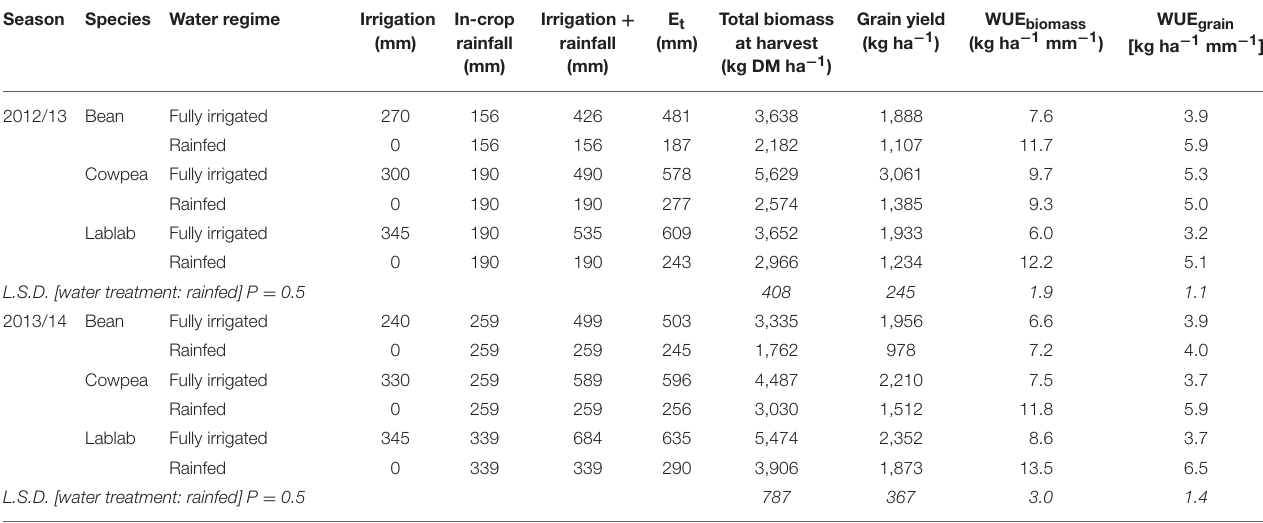
TABLE 6 | Irrigation, rainfall, water use (E t ), and water use efficiency for biomass production and grain yield of short-season legume species grown under different water regimes in Machakos, Eastern Kenya during the short rains of 2012/13 and 2013/14. Season Species Water